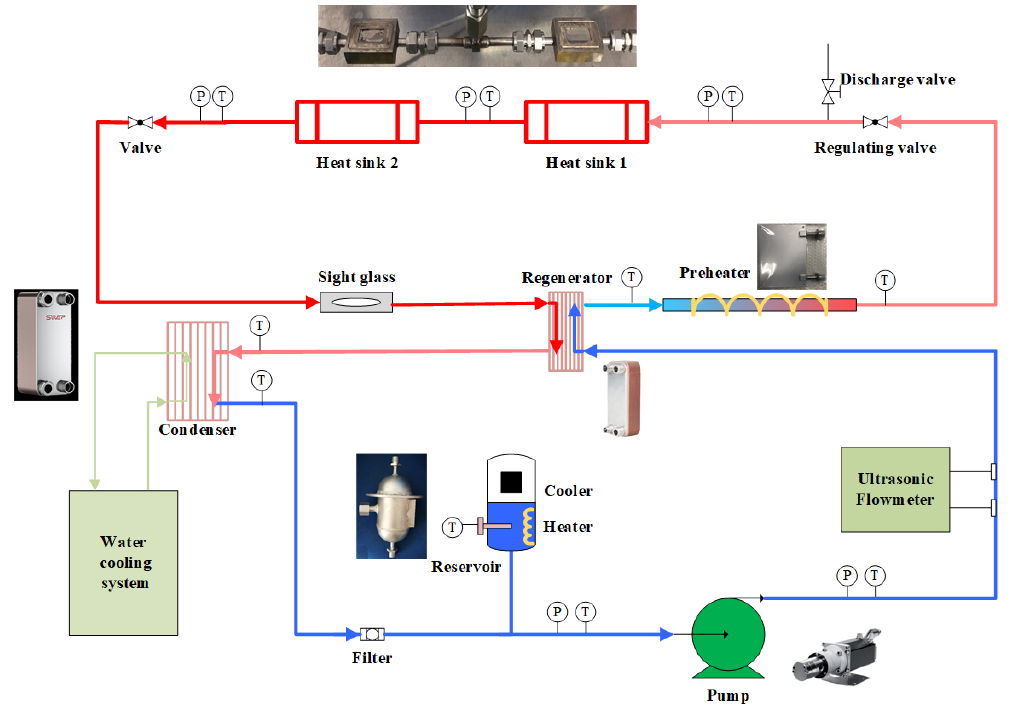
Figure 1. Schematic diagram of pumped fluid loop system for solar cooling.